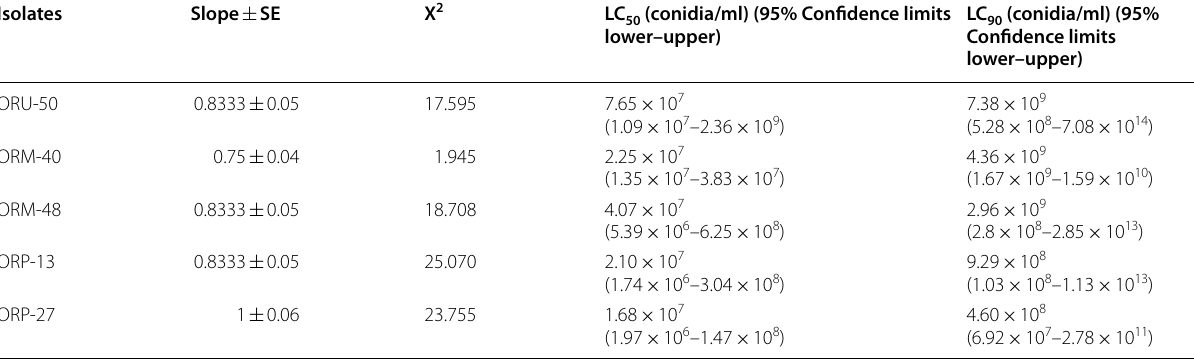
Table 3 LC and LC values of the isolates against second-instar larvae of Spodoptera littoralis at 13 days after treatment 50 90 Isolates Slope SE X 2 LC 50 (conidia/ml) (95% Confidence limits ±